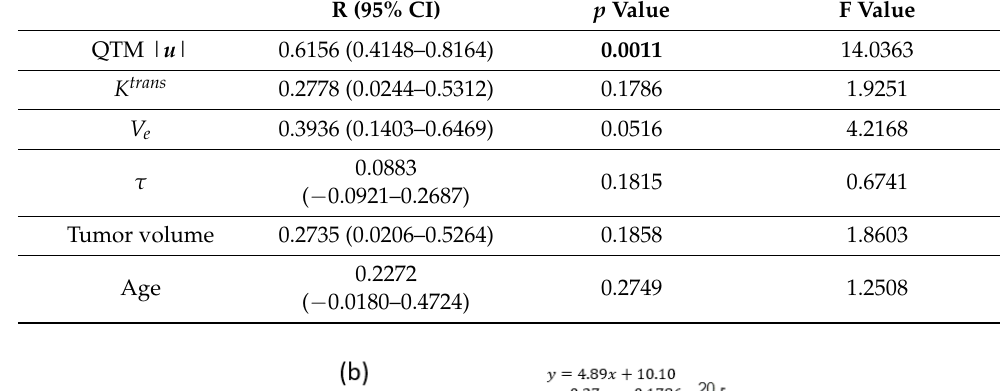
Table 1. Spearman correlation with LSF.